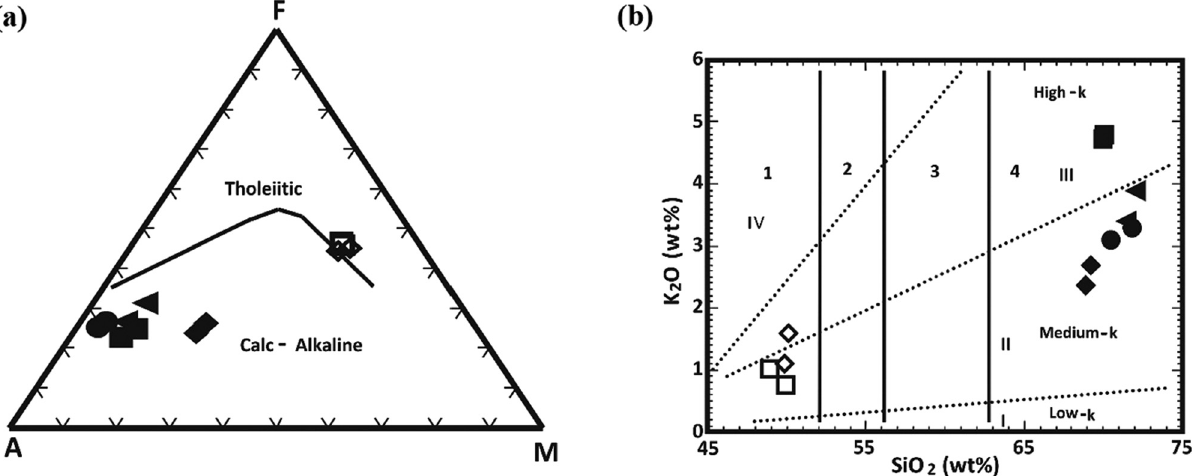
Figure 5: ( a ) A – F – M diagram for di ff erent dikes. Fields, after Irvine and Baragar [ 25 ] ; symbols as in Figure 4. ( b ) K 2 O vs SiO 2 diagram for di ff erent dikes ( Peccerillo and Taylor [ 26 ]) . 1 = basalt, 2 = basalt andesite, 3 = andesite, 4 = dacite and rhyolite, I = arc - tholeiitic, II = calc - alkaline, III = high K - calc - alkaline, and IV = shoshonite; symbols as in Figure